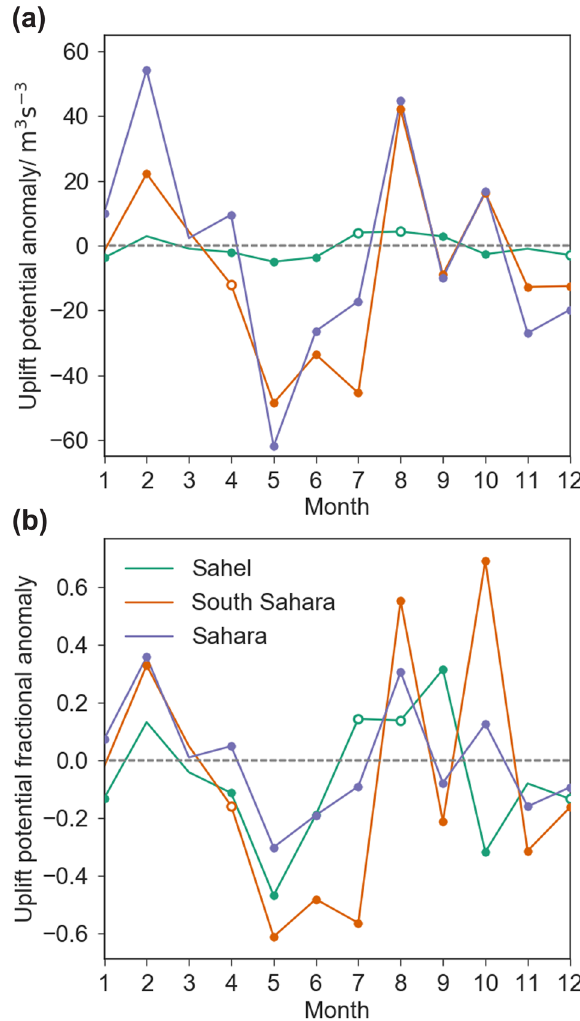
Fig. 4 Seasonal cycle in the forced change to DUP between P25 and CP4. a Absolute difference in the forced change to DUP: (P25FC-P25) – (CP4FC-CP4) and b difference in the forced change to DUP as a fraction of P25 current climate DUP: (P25FC-P25) – (CP4FC- CP4))/P25. Circles show statistically signi fi cant points at the 5% ( fi lled) and 10% (hollow)